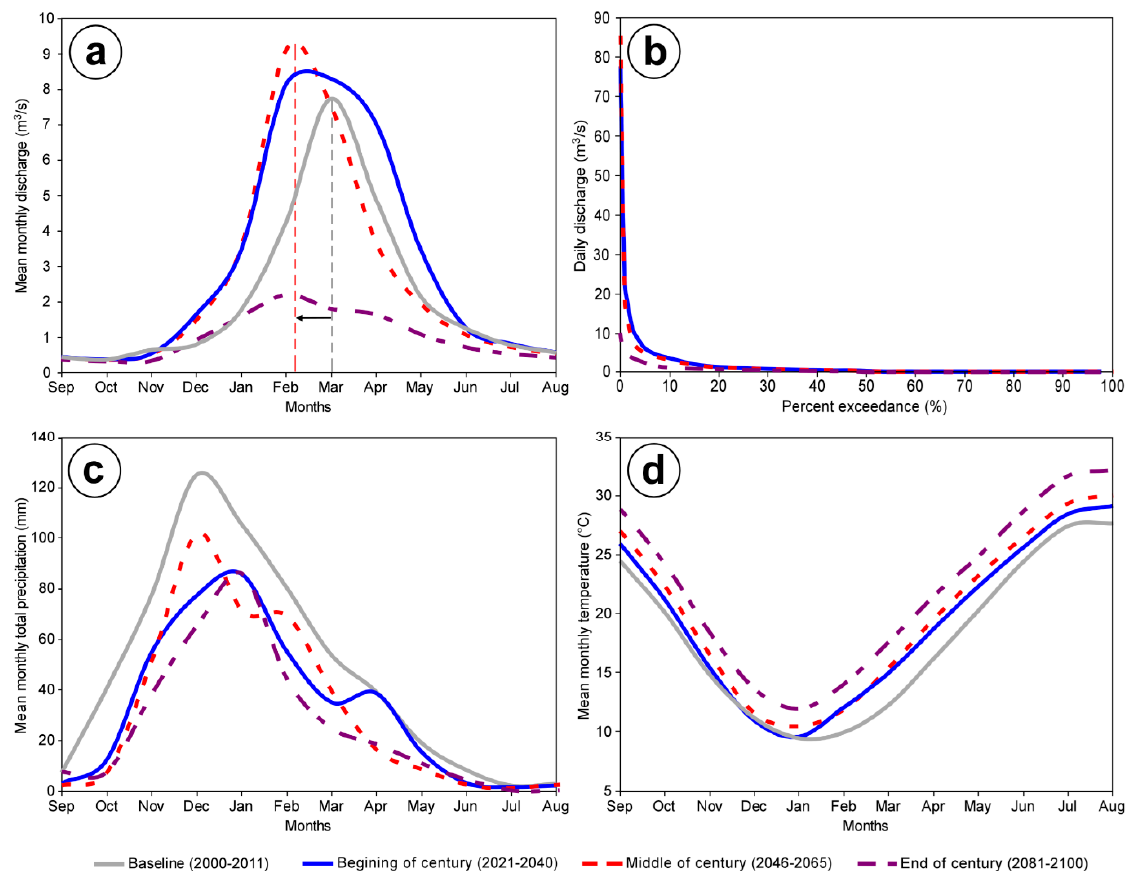
Figure 8. Graphs showing the ( a ) mean monthly discharge, ( b ) flow duration curve, ( c ) mean monthly precipitation and ( d ) mean monthly temperature for the baseline, beginning of the century, middle of the century and end of the century simulations at the Alata River Basin outlet.